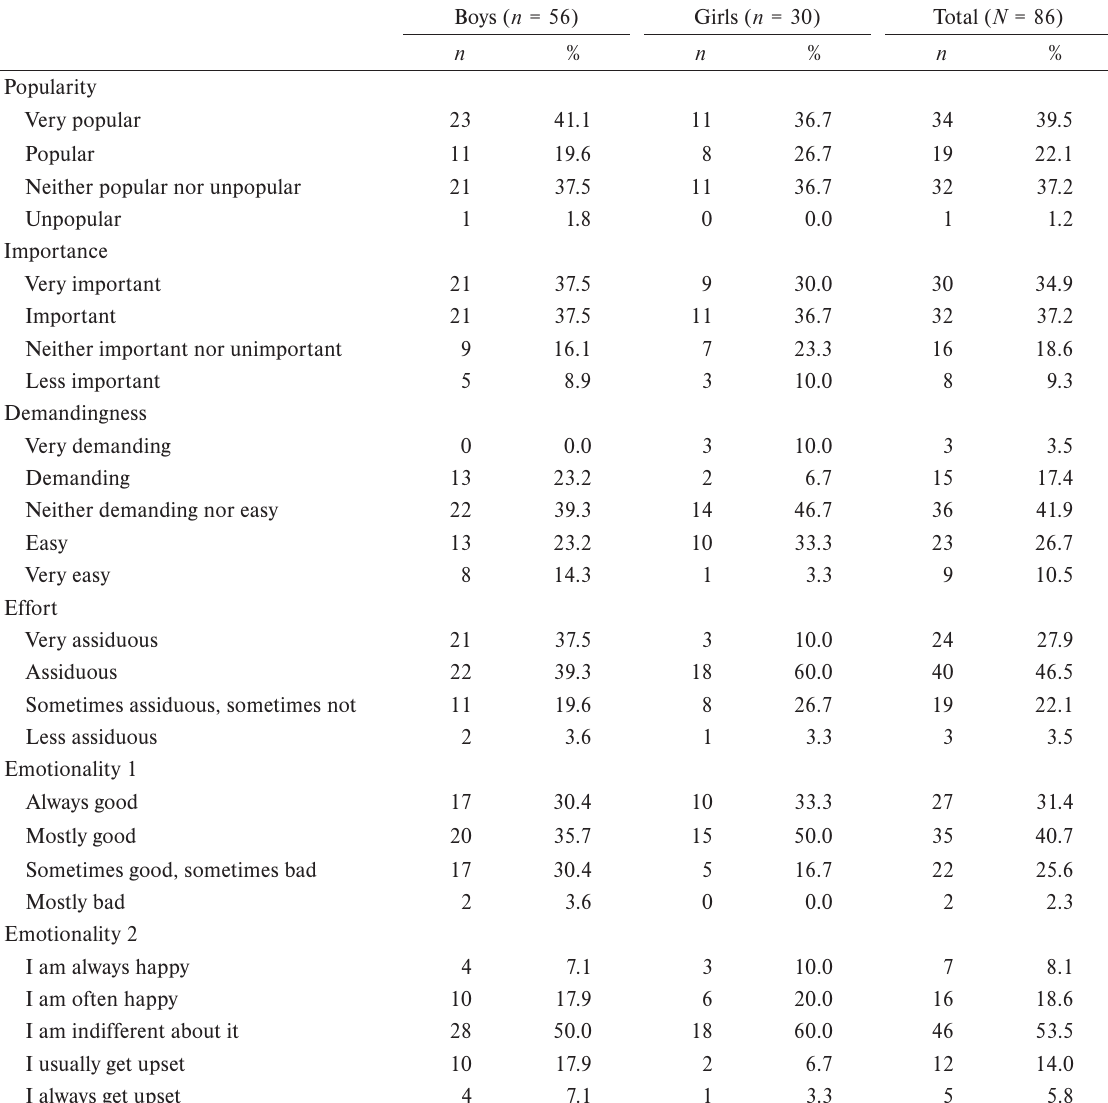
Table 2 Intergroup comparison of absolute and relative frequencies of pupils attitudes towards physical education by gender